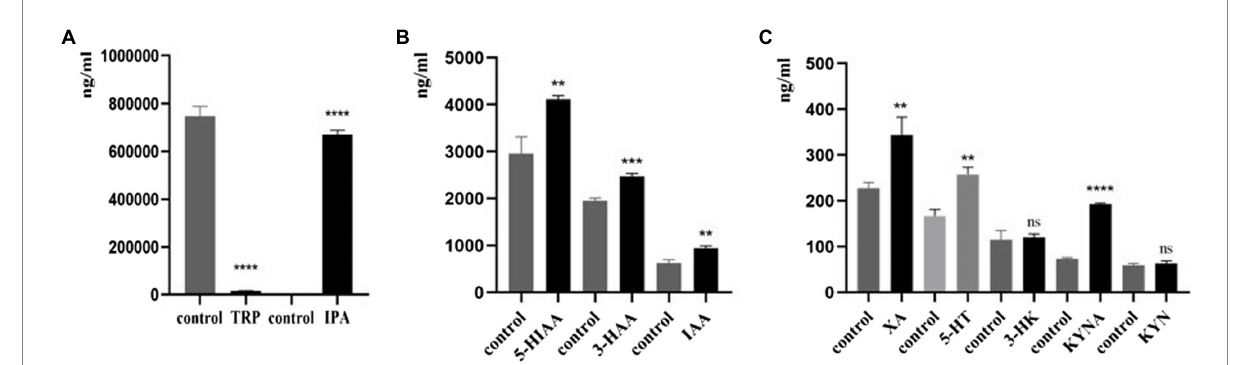
FIGURE 6 Effects of C. sporogenes on TRP metabolites. Effects of C. sporogenes on (A) TRP and IPA; ( B ) 5-HIAA, 3-HAA, and IAA; ( C ) XA, 5-HT, 3-HK, KYNA, and KYN (* p < 0.05, ** p < 0.01, *** p < 0.001, **** p < 0.0001 vs. control